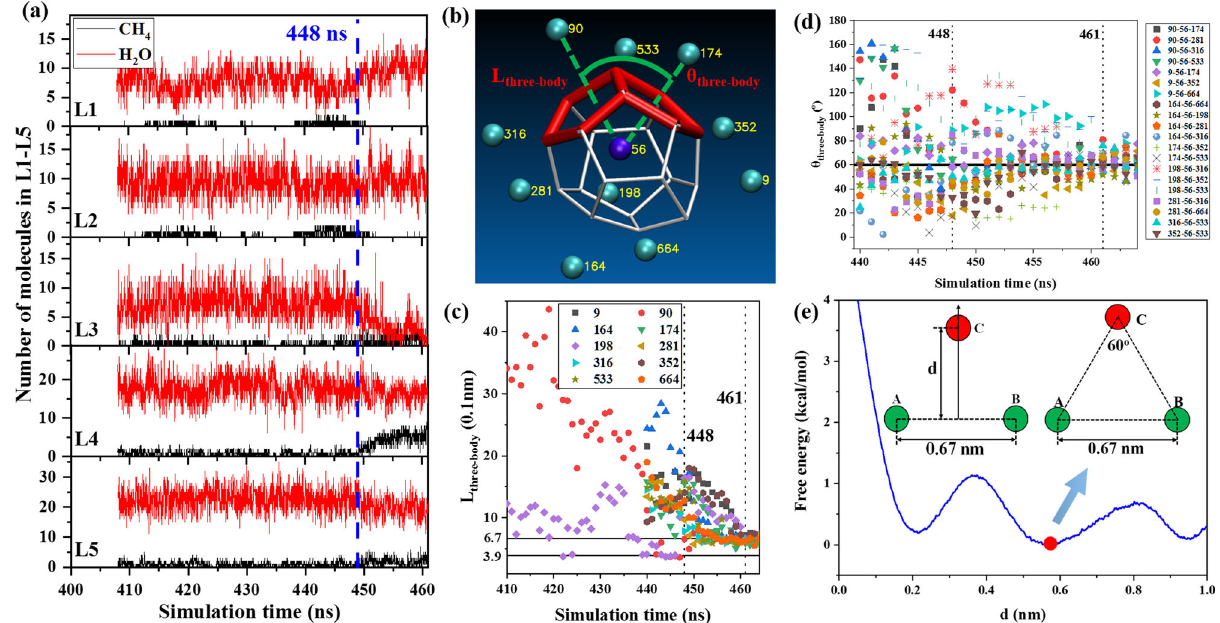
Fig. 5 Gas aggregation characteristics around the central methane during hydrate nucleation (box A). a Change of numbers of methane and water molecules in the L1 – L5 layers. The layers are distributed by the distance to central methane. L1 ≤ 0.4 nm, 0.4 nm < L2 ≤ 0.5 nm, 0.5 nm < L3 ≤ 0.6 nm, 0.6 nm < L4 ≤ 0.7 nm, 0.7 nm < L5 ≤ 0.8 nm. b A typical formed methane hydrate 5 12 cage and the neighbor methane in region A. Balls represent different methane molecules (the central methane: blue; others: cyan) and their ids are recorded in yellow. A fi ve-membered ring as well as its neighbor with one common ring are marked in red. c Change of L three-body during hydrate nucleation. Two methane with id 90 and 198 are shown from 410 ns and the rest are shown from 440 ns for clarity. d The angle θ three-body varying with time during hydrate nucleation. e Free energy of the three-body interactions for methane in water at 50 MPa and 250 K. Methane A, B are frozen and methane C locates at the perpendicular bisector of methane A and B. d is a reaction coordinate which is the vertical distance of methane C with A and B. The red ball indicates the minimum of free energy